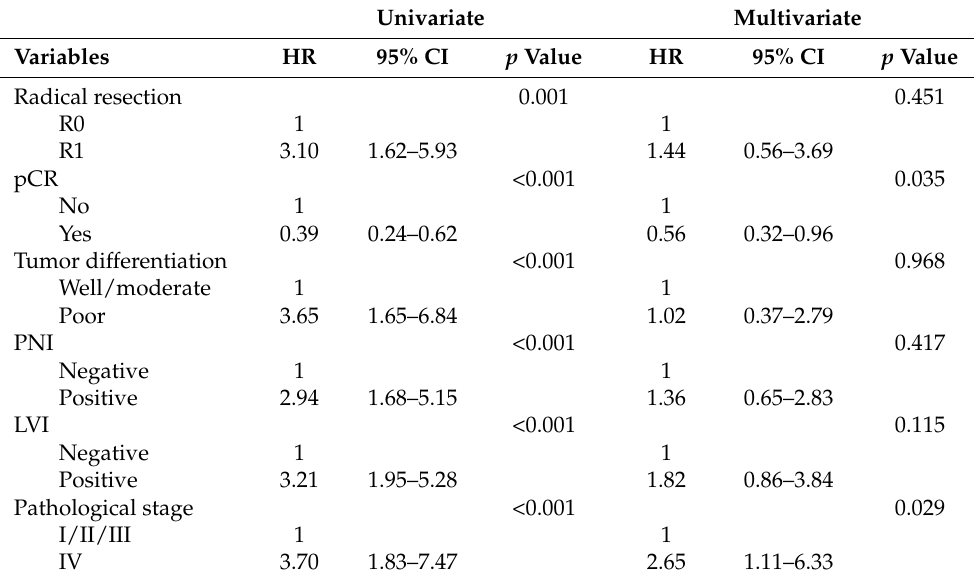
Table 3. Univariate and multivariate Cox regression model for disease-free survival.